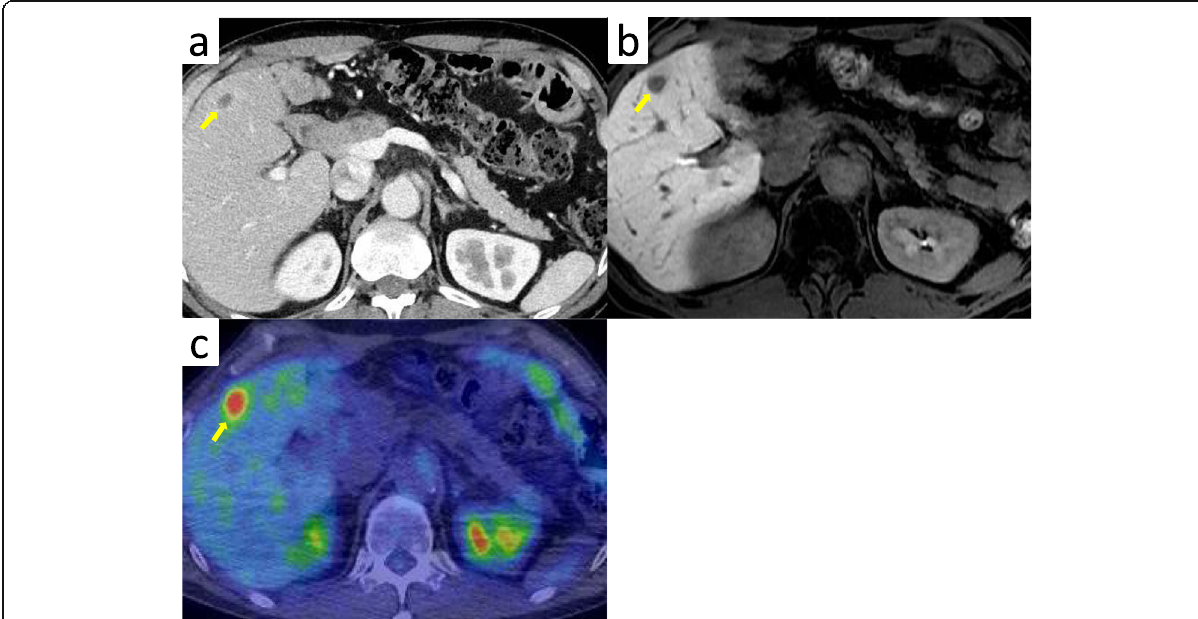
Fig. 4 a Contrast-enhanced CT showing a 10-mm low-density area in liver segment 5 (arrow). b Gd-EOB-DPTA – enhanced MRI showing a well- defined mass in liver segment 5 (arrow). c PET/CT showing the liver mass with high fluorine-18-fluorodeoxyglucose uptake (arrow). CT, computed tomography; Gd-EOB-DPTA, gadolinium-ethoxybenzyl-diethylenetriamine; MRI, magnetic resonance imaging; PET, positron emission tomography